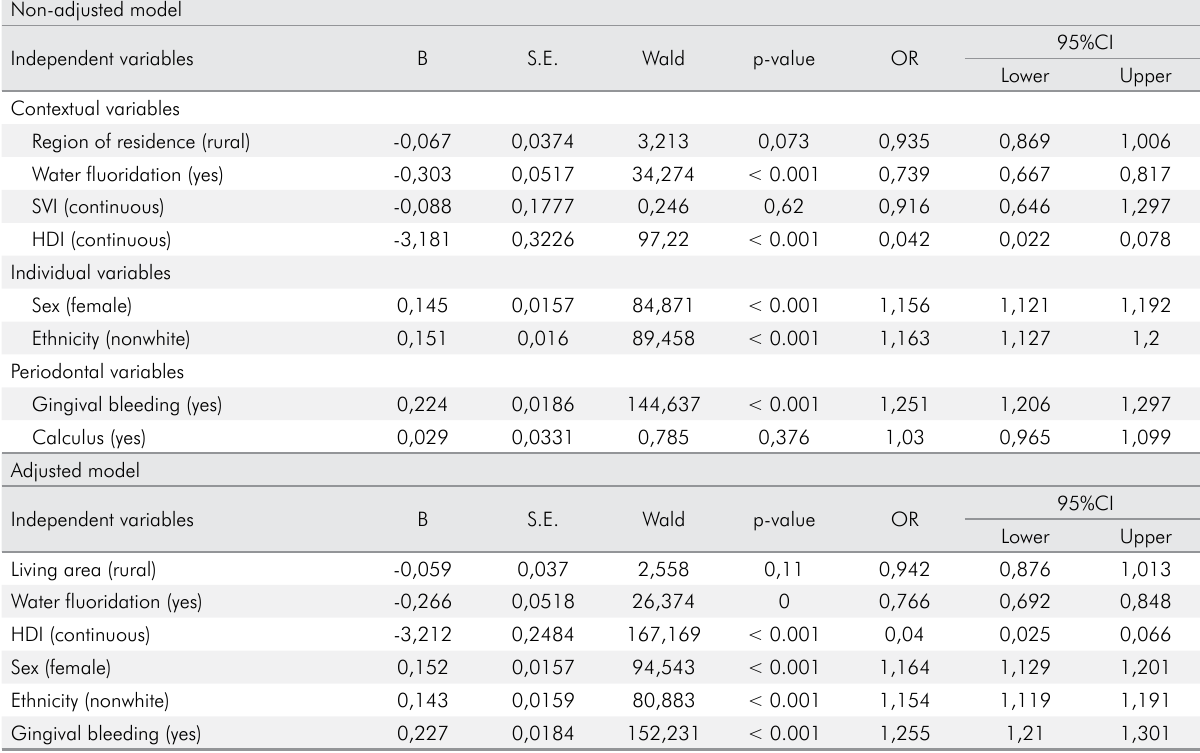
Table 3. Non-adjusted and adjusted multivariate Poisson regression model that assessed factors associated with dental caries experience in 12-year-old children (n =